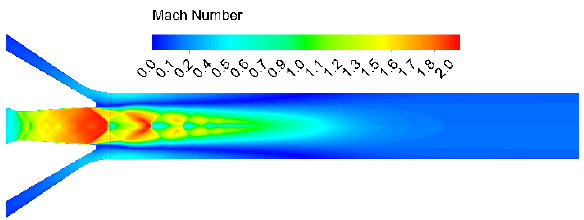
Fig. 12. Contours of Mach number for relative back-pressure p 4 /p 02 = 1.77 (172 kPa abs).